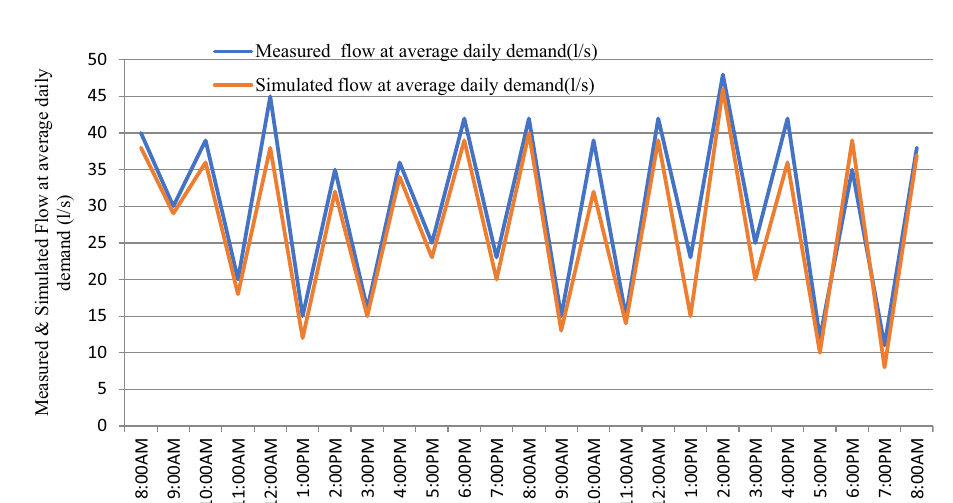
Fig. 6 Calibration of pipe flow during average daily demand at pipe